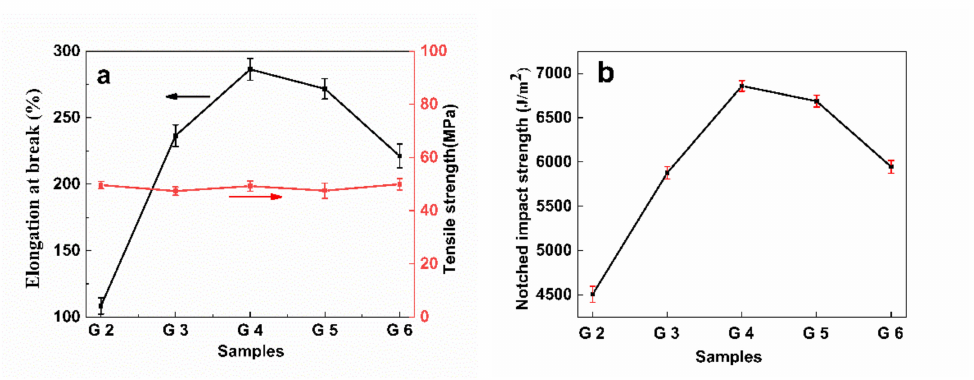
Figure 11. Effect of grafted monomers on the mechanical properties of PLA/PPC and the PLA/PPC/PLA-g-GMA blends; (G2: PLA/PPC; G3: PLA/PPC/PLA-g-GMA; G4: PLA/PPC/PLA-